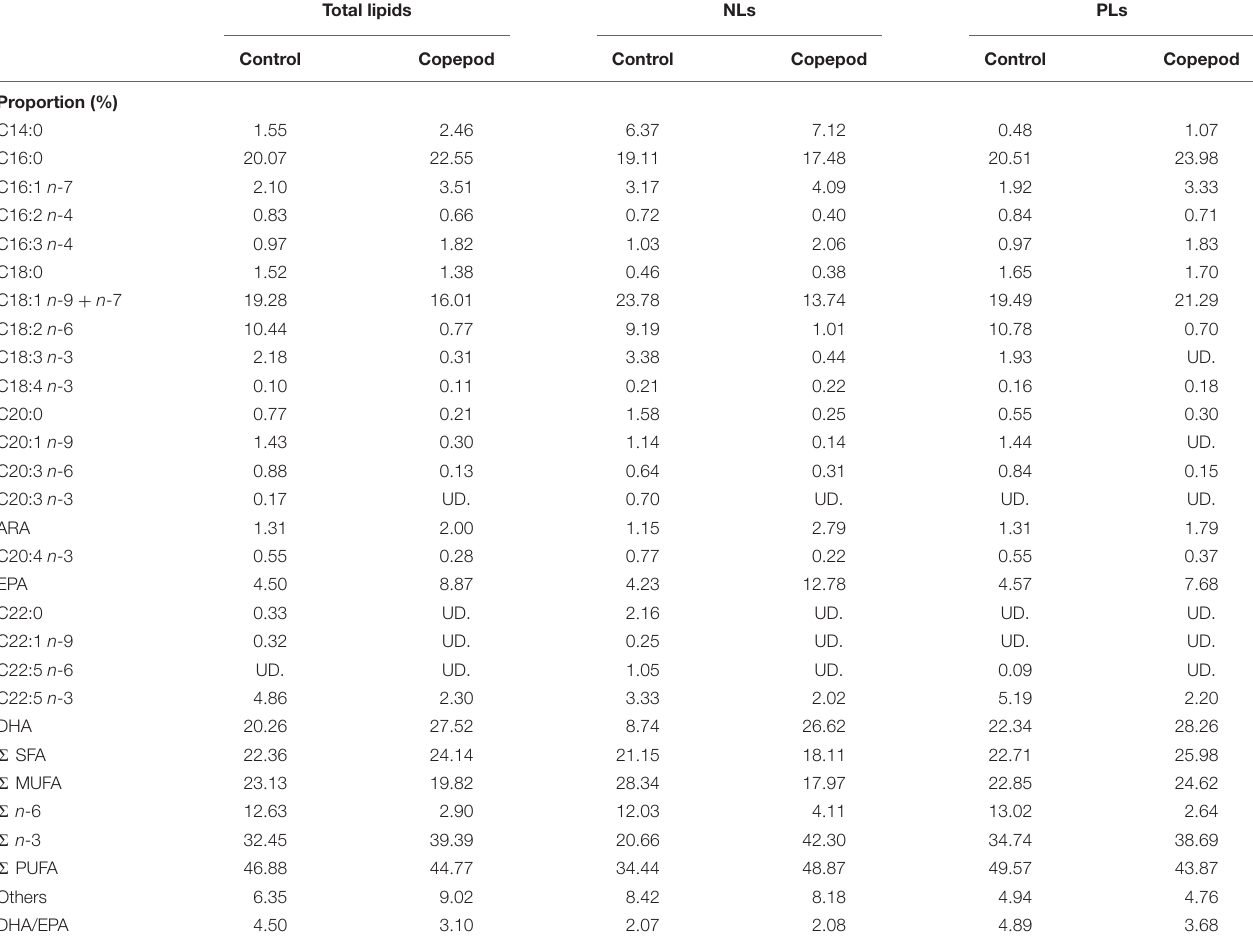
TABLE 6 | Fatty acid composition of total lipids, non-polar lipids (NLs), and polar lipids (PLs) of Pagrus major larvae at the end of rearing periods (20 days post hatching). Total lipids NLs PLs Control Copepod Control Copepod Control